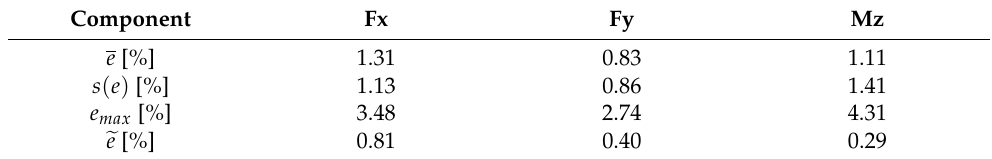
Table 2. Relative error statistics of 13 calibrations performed during the measurements campaign.